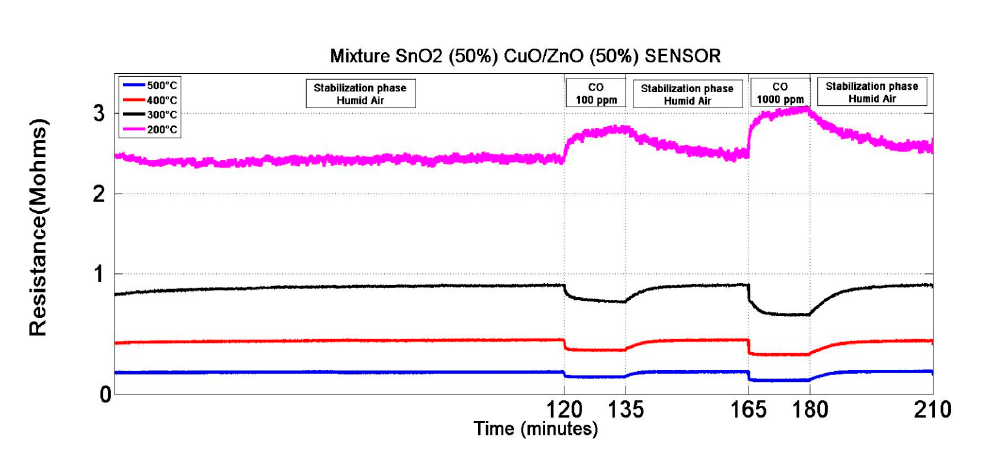
Figure 5. Responses of gas sensor at different operating temperatures for the MOS: mixture SnO 2 (50%) and CuO 75% /ZnO 25%